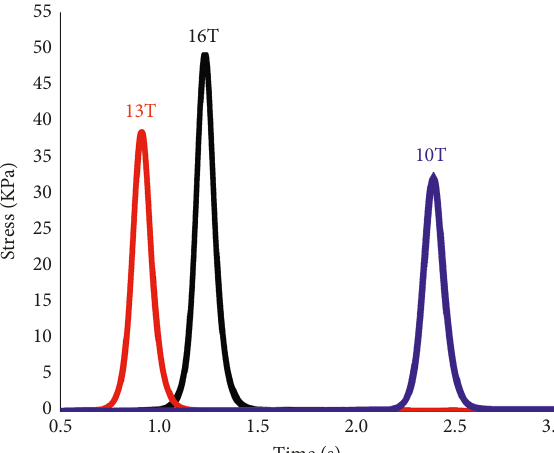
Figure 15: Stress in the single-axle loading mode.